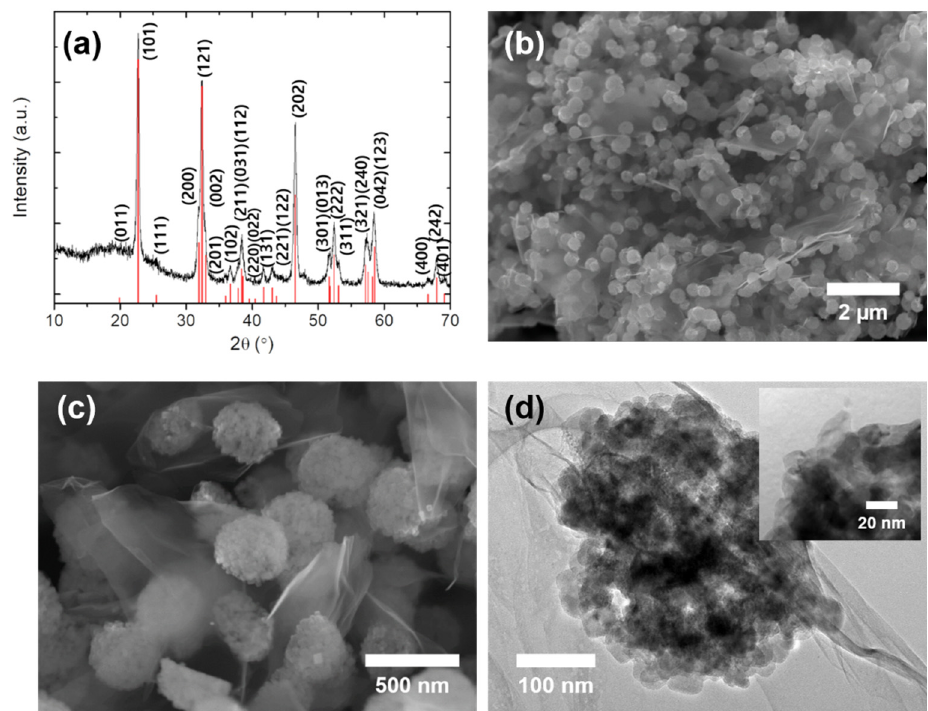
Figure 2. ( a ) XRD pattern (red columns: the standard peaks of NaCoF 3 , JCPDS No. 70-1889), ( b , c ) SEM images, and ( d ) TEM images of the NCF/rGO nanocomposites (inset: high-magnification the TEM image).